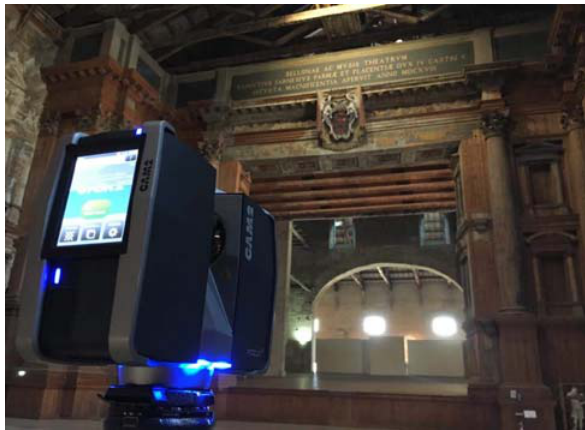
Figure 4. “ Faro Cam2, Focus 3D, 150 ” laser scanning during a survey